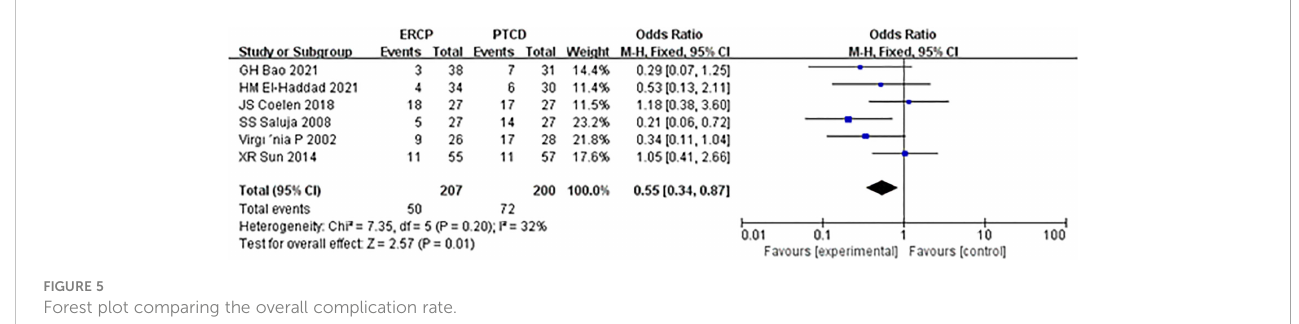
FIGURE 5 Forest plot comparing the overall complication rate.